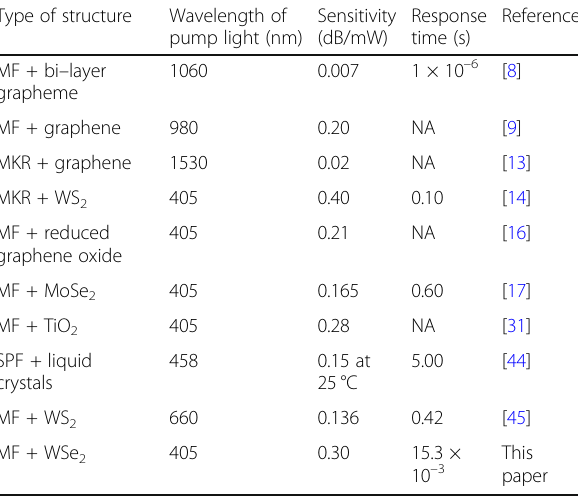
Table 1 Comparison of different light - control - light devices Type of structure Wavelength of Sensitivity Response pump light (nm) (dB/mW) time (s)